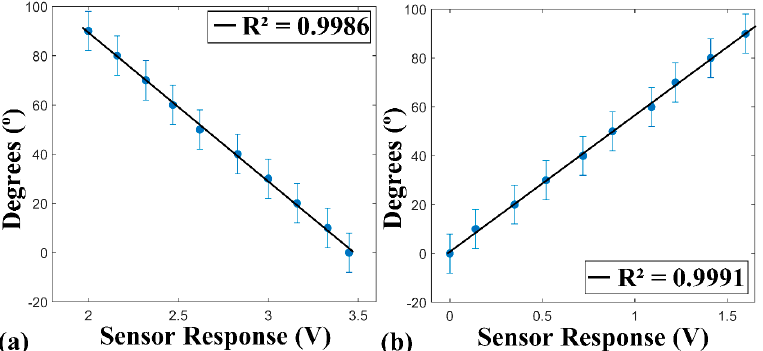
Figure 4. Results of quasi-static test for: ( a ) POF sensor and ( b ) potentiometer. The market point (blue points) are the values of the sensor response and the black line is the result of the linear regression.